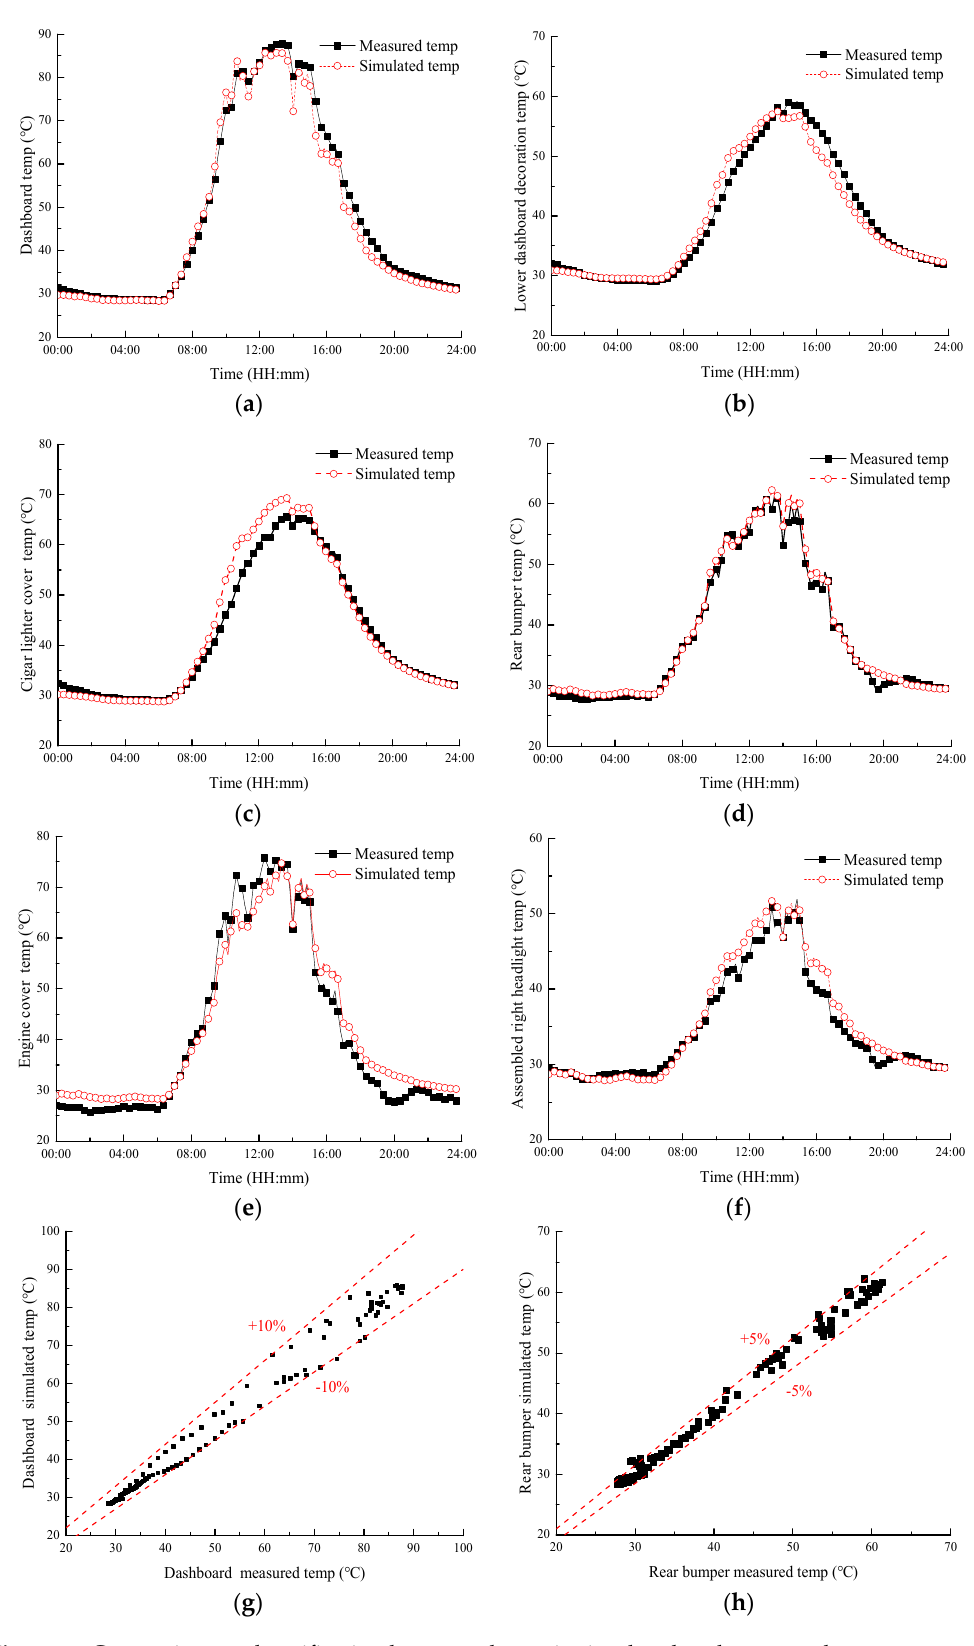
Figure 6. Comparison and verification between dynamic simulated and measured temperature of key parts: ( a ) dashboard temperature; ( b ) lower dashboard decoration temperature; ( c ) cigar lighter cover temperature; ( d ) bumper temperature; ( e ) engine cover temperature; ( f ) headlight temperature; ( g ) relative error of dashboard temperature; and ( h ) relative error of rear bumper temperature.